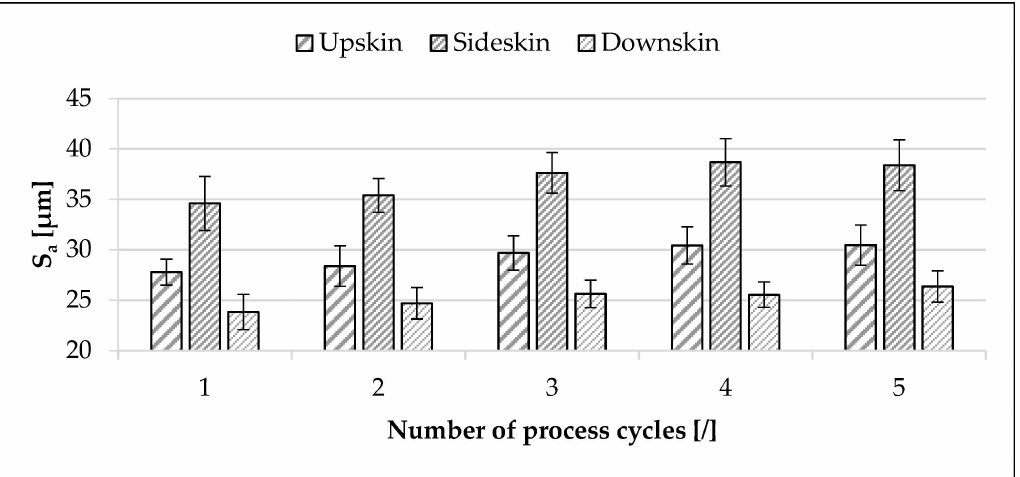
Figure 15. Influence of cyclic reuse on surface roughness (S a ) of the specimens manufactured from the used polyamide 12 sinter material. Five process cycles were considered. The upskin, sideskin, and downskin-surfaces were analyzed. The refresh rate was 30